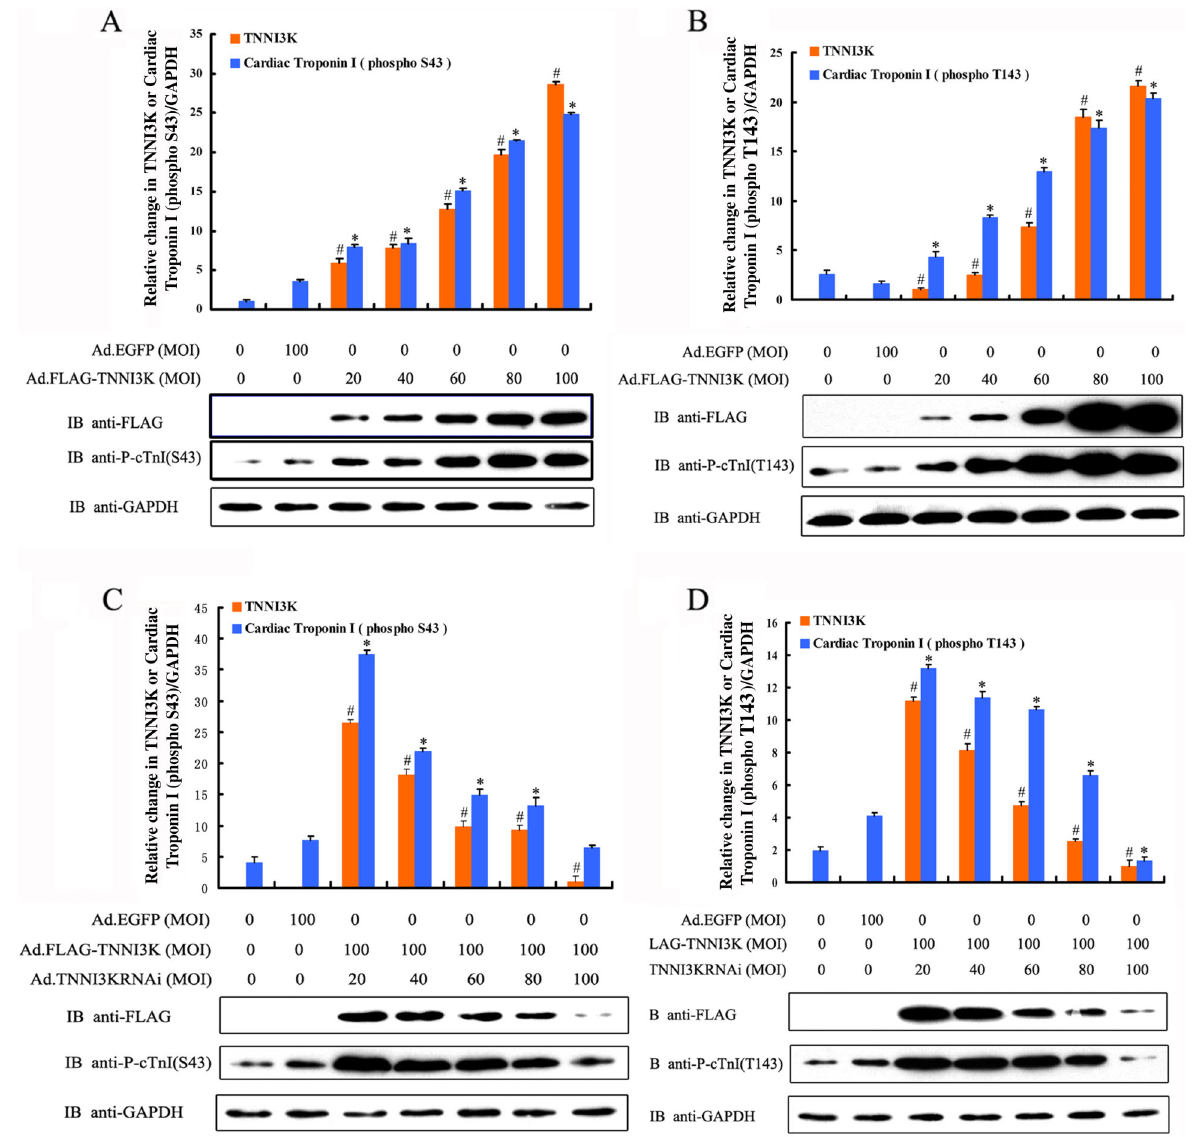
Figure 3. The expression of human cardiac troponin I-interacting kinase (TNNI3K) correlates with the phosphorylation of cardiac troponin I (cTnI) at Ser43 (S43) and Thr143 (T143). Rat cardiac myocytes were infected with adenoviral vectors with multiplicity of infections (MOIs) of 20, 40, 60, 80, or 100 for 24 h. Cell lysates were then subjected to Western blot analysis to detect the expression of rTNNI3K as well as the phosphorylation of cTnI at Ser43 and Thr143 and glyceraldehyde-3-phosphate dehydrogenase (GAPDH) as an internal control. Overexpression of rTNNI3K produces a significant increase in the phosphorylation of cTnI at Ser43 ( A ) and Thr143 ( B ). Knockdown of rTNNI3K with Ad.rTNNI3KRNAi significantly reduces phosphorylation at Ser43 ( C ) and Thr143 ( D ) of cTnI. Data were from five independent experiments. Data are reported as means ± SE. *P , 0.01 vs blank control (without virus infection). # P , 0.01 vs cardiomyocytes infected with Ad.EGFP (one-way